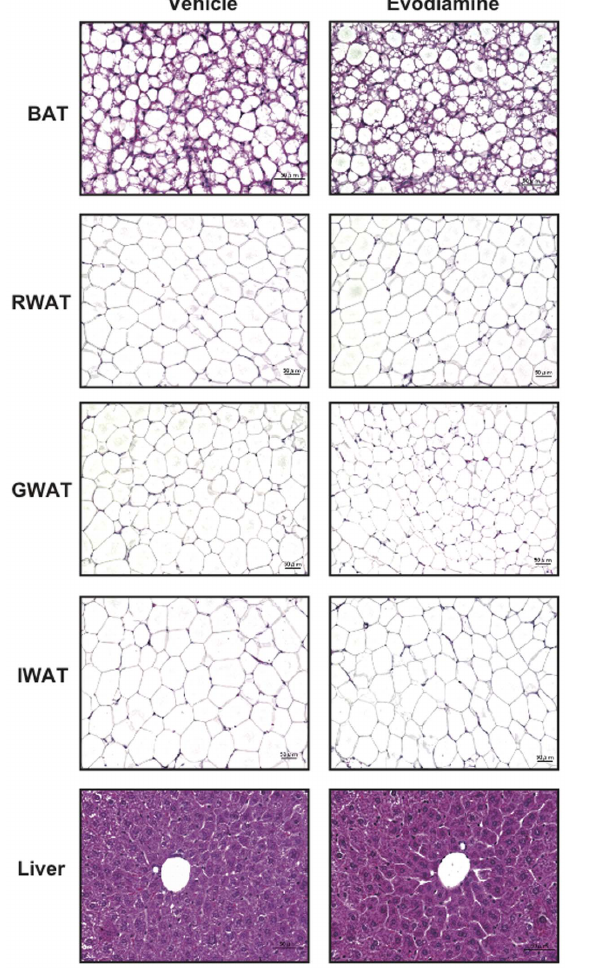
Figure 2. Histological analysis of BAT, RWAT, GWAT, IWAT and liver in KK-Ay mice treated with evodiamine. Tissue samples were collected from the mice treated with evodiamine for 7 days. Tissue sections of brown adipose tissue (BAT), retroperitoneal (RWAT), gonadal (GWAT), inguinal white adipose tissues (IWAT) and liver were stained with hematoxylin and eosin.